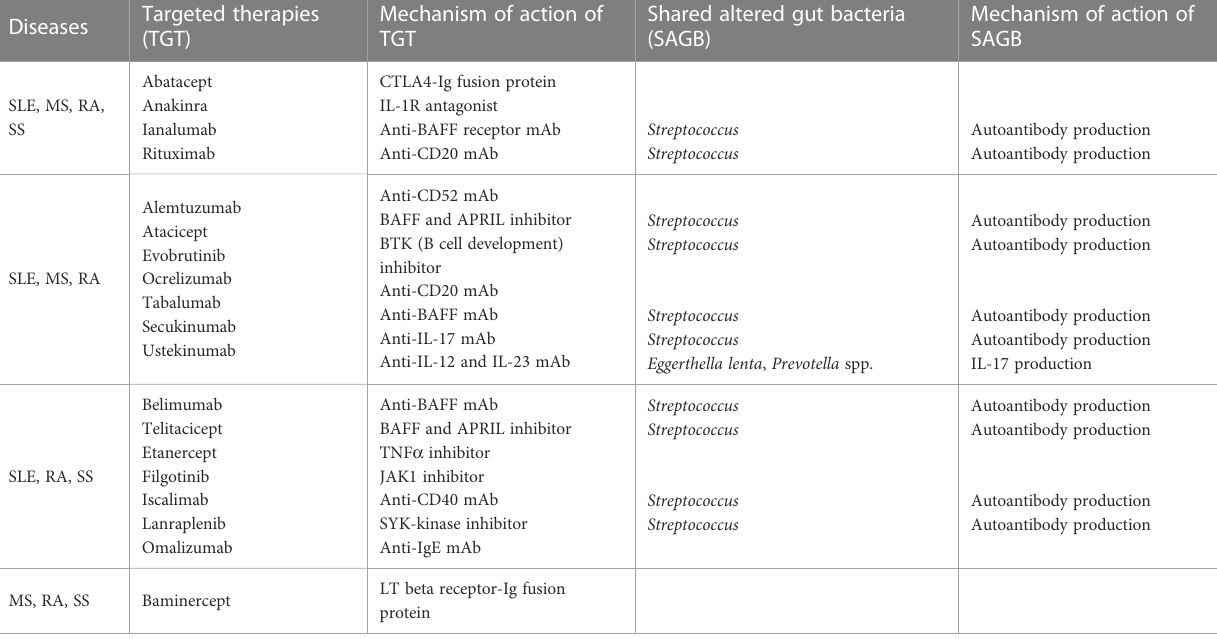
TABLE 4 Targeted therapies and commensal bacteria shared by four autoimmune